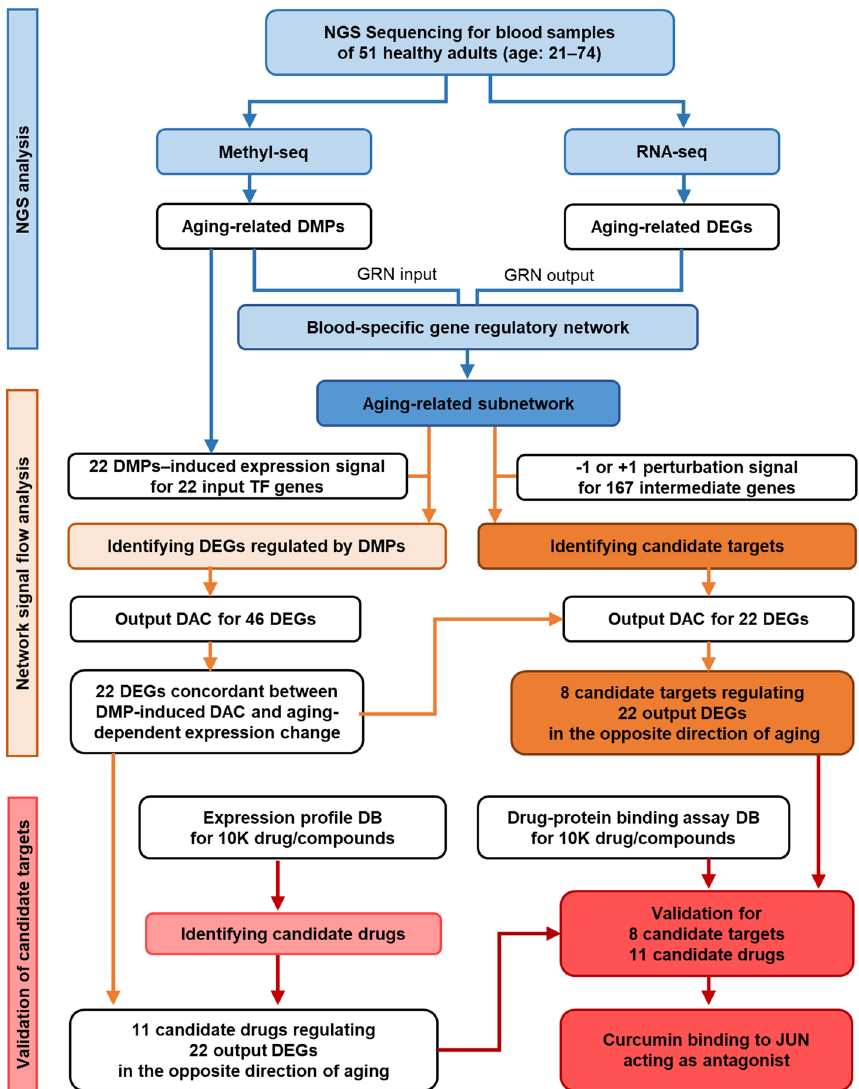
Figure 1. Schematic workflow of multi-dimensional investigation for identifying candidate targets to reversely regulate the DEG